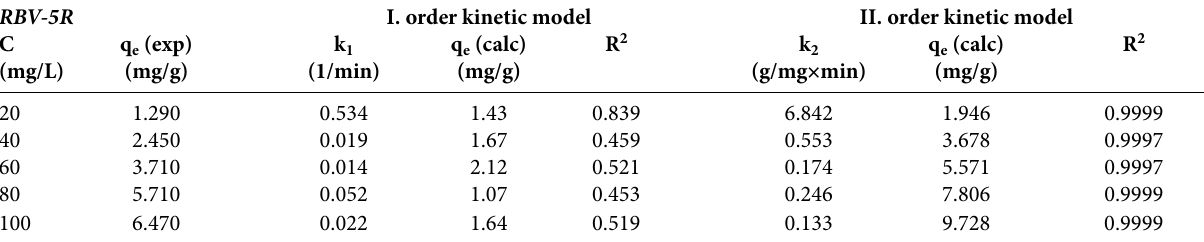
Table 5. Parameters of kinetic models (C i = 20–100 mg/L, 1.5 g biomass, 160 µm, 700 rpm, pH = 6.0 ± 0.2, T = 20 ± 1 °C, P = 1atm)